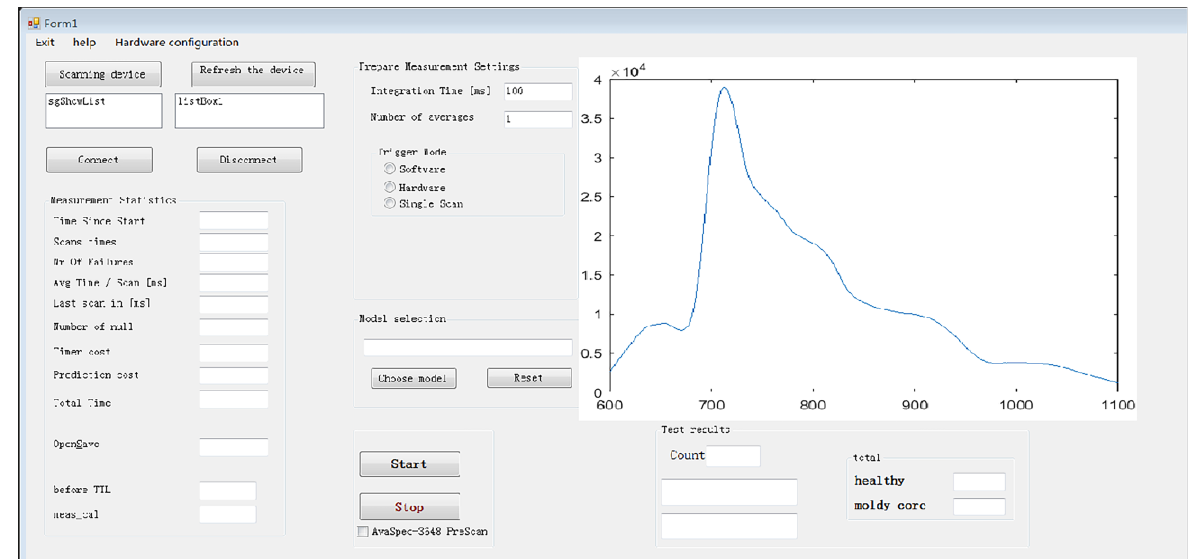
Figure 3. The program interface diagram.